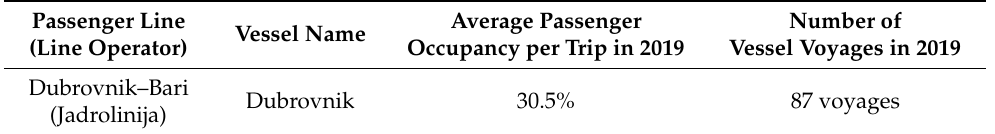
Table 13. Passenger lines serviced in 2019 for the existing Dubrovnik–Bari route.